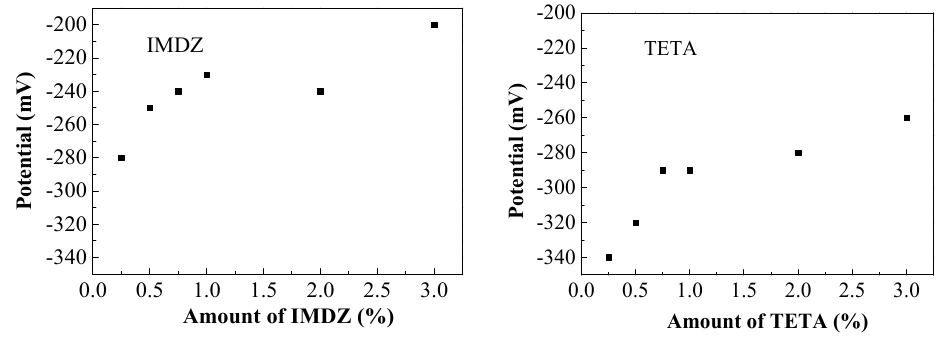
Figure 10. Corrosion potentials of the steel bars.